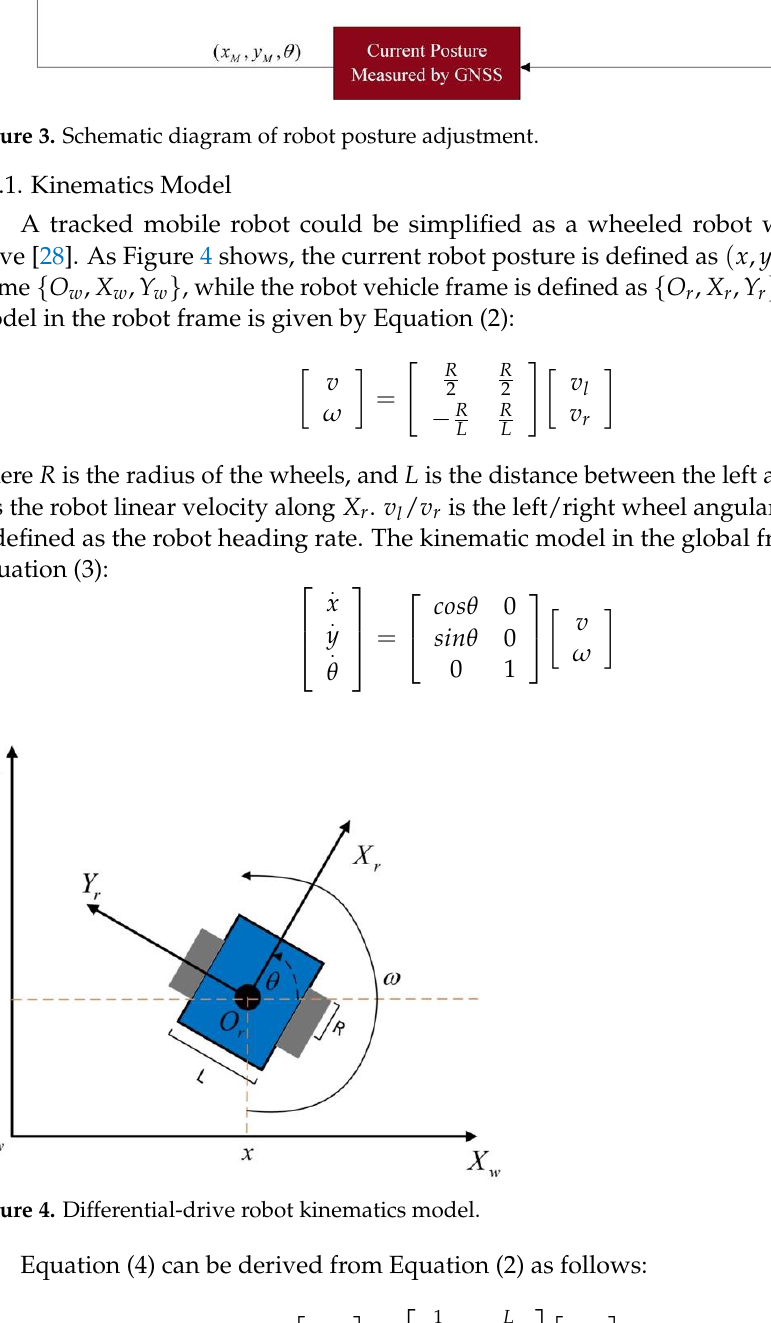
Figure 4. Differential-drive robot kinematics model.